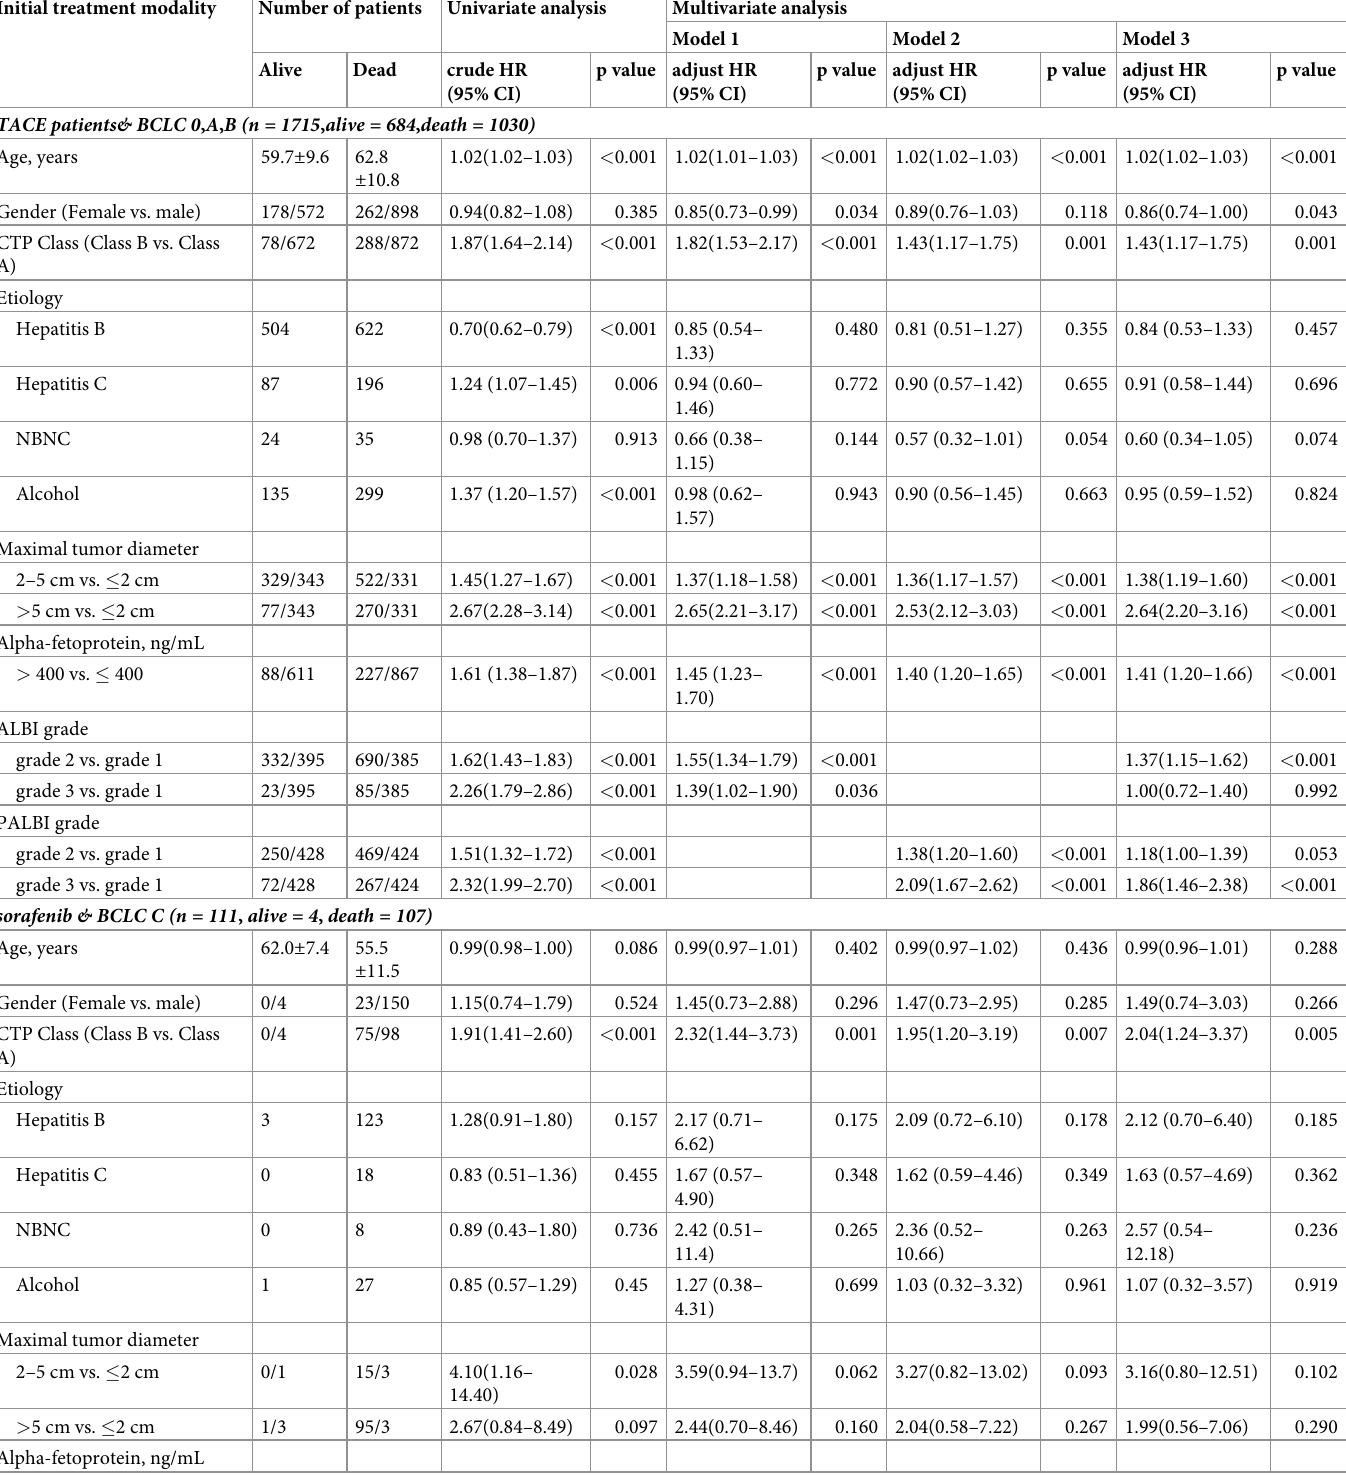
Table 6. Multivariate cox regression analysis on survival according to palliative treatment modalities with BCLC